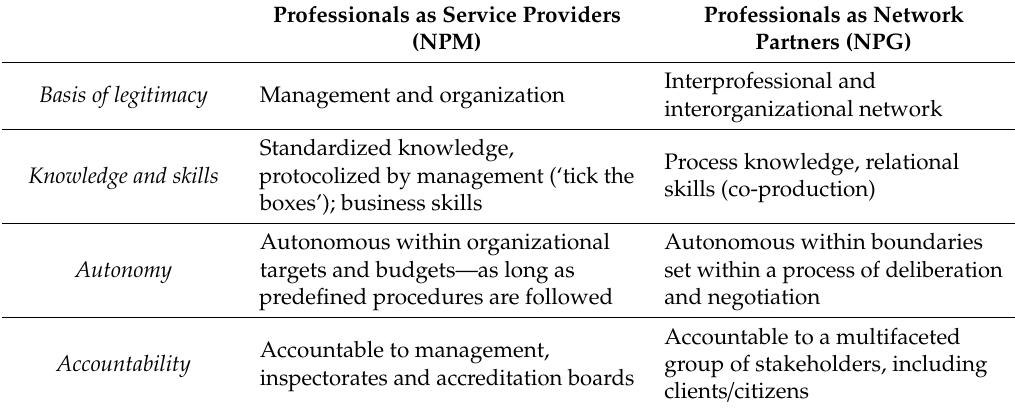
Table 1. Professional role characteristics in new public management (NPM) and new public governance (NPG)